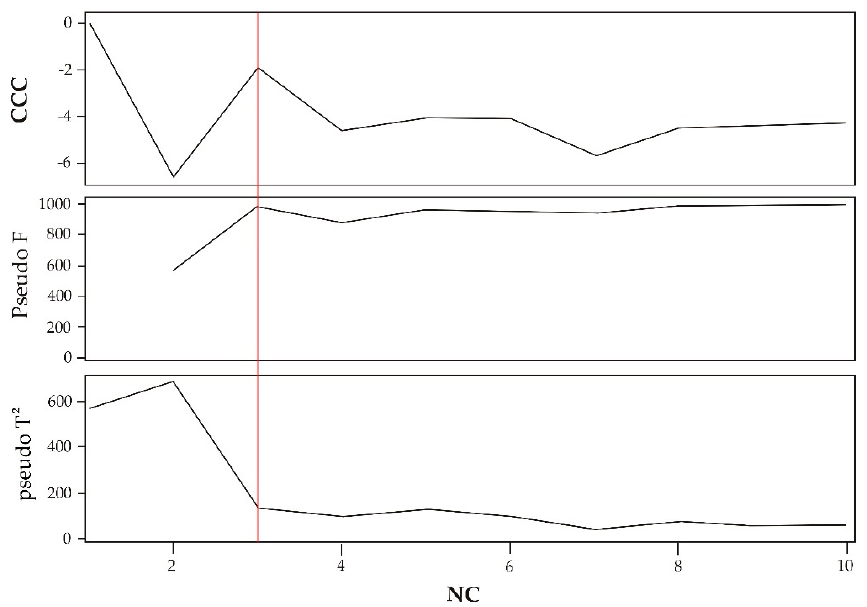
Figure 5. Statistical criteria for determining the number of groups to be established. CCC = Cubic Clustering Criterion. NC = Number of clusters.